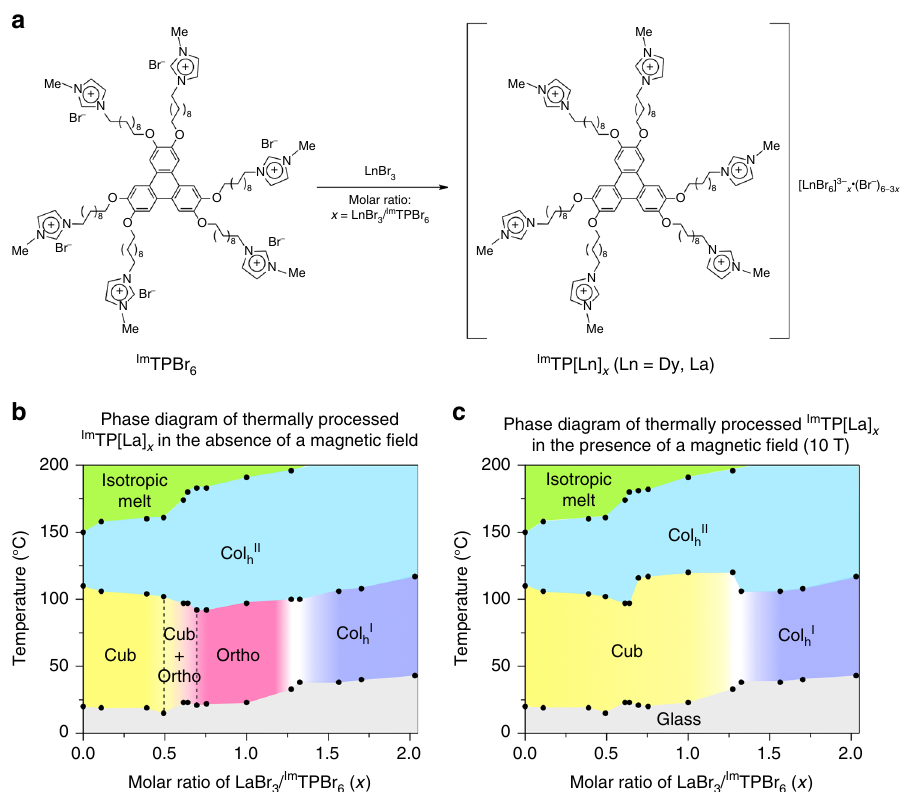
Fig. 1 Chemical structures of Im TPBr 6 and Im TP[Ln] x (Ln = Dy, La), and phase diagrams of Im TP[La] x . a Preparation of composites Im TP[Ln] x . b , c Phase diagrams of Im TP[La] x after thermal processing in the absence ( b ) or presence ( c ) of a 10-T magnetic fi eld. Cub cubic, Ortho orthorhombic, Col h hexagonal columnar. The boundaries of the white regions could not be clearly